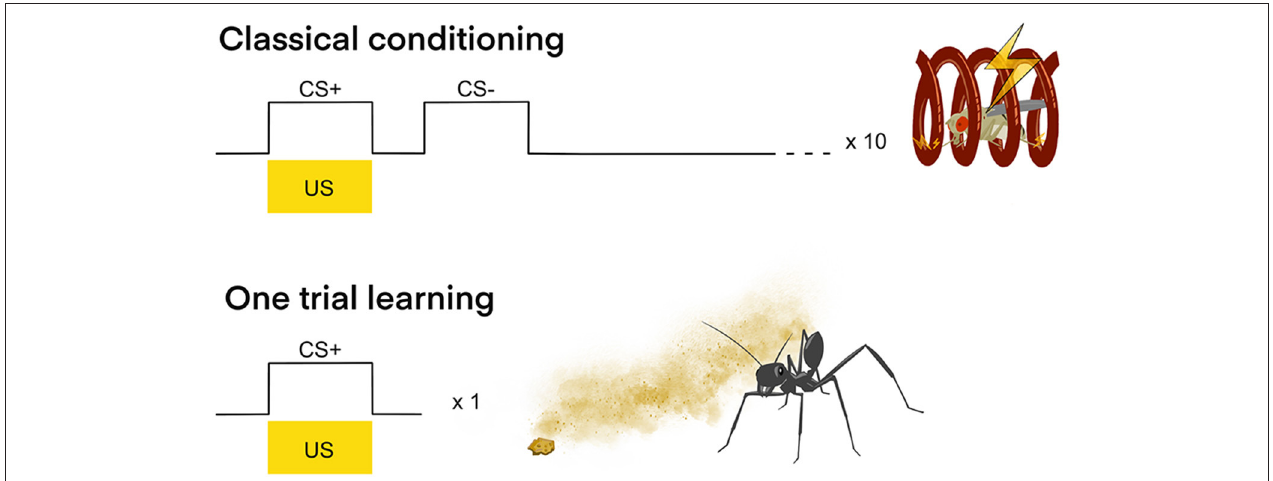
FIGURE 2 | Classical conditioning vs. one trial learning. Classical conditioning : In classical olfactory conditioning with D. melanogaster one odor (CS + ) is presented together with an electric stimulus (US) and another odor (CS–) is presented without US. Generally, several (e.g., 10) interspaced trials are conducted in order for the insect to from an LTM and learn to associate the CS + with the US. One trial learning : In contrast to classical conditioning, one trial learning only requires one experience of the CS + together with the US in order for the insect to show LTM formation. The example shows the desert ant Cataglyphis fortis , that after only once experiencing an innately neutral odor together with a food crumb, will target this odor immediately on consecutive foraging runs ( Huber and Knaden, 2018).